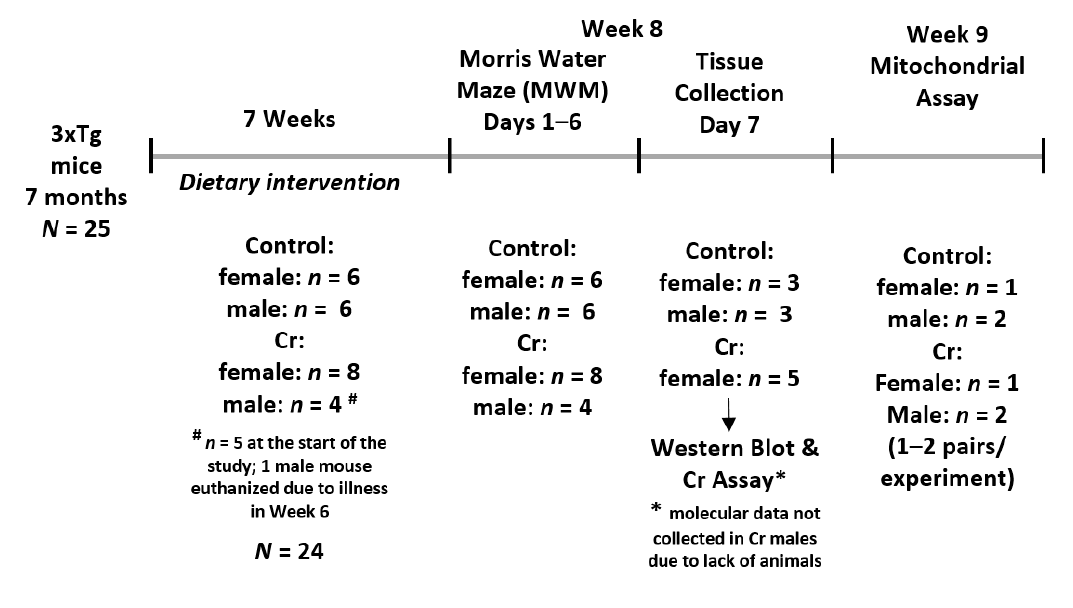
Figure 2. Experimental timeline of the study.